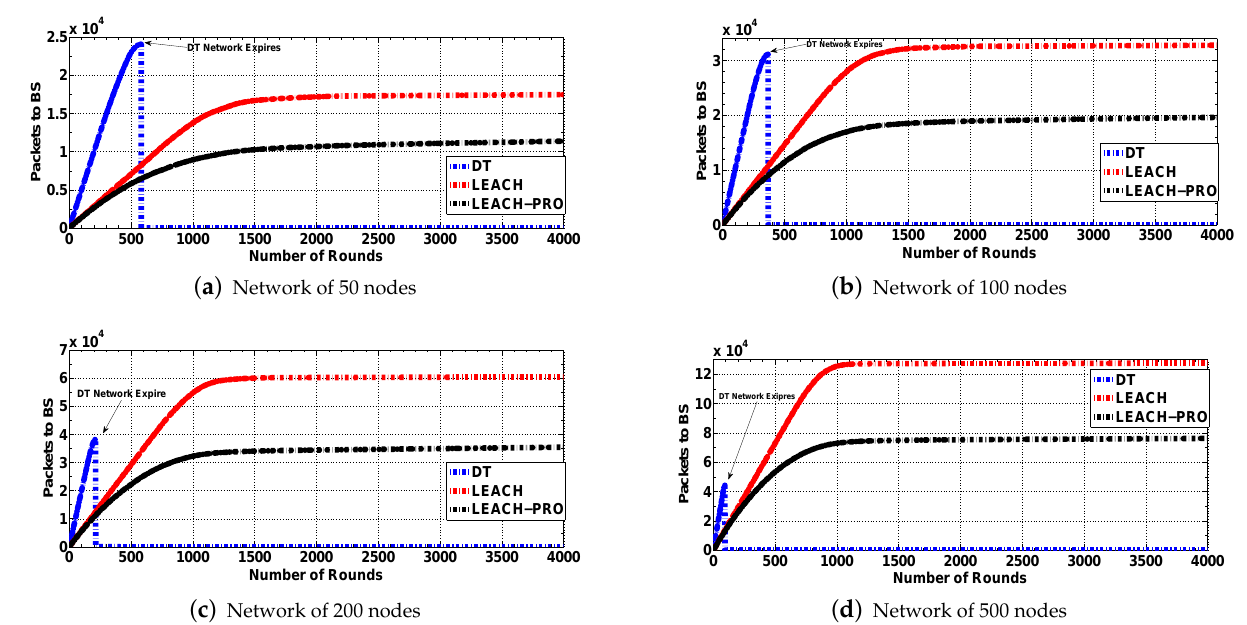
Figure 15. Traffic load evolution under varying network densities. Network of ( a ) 50, ( b ) 100, ( c ) 200, ( d ) 500